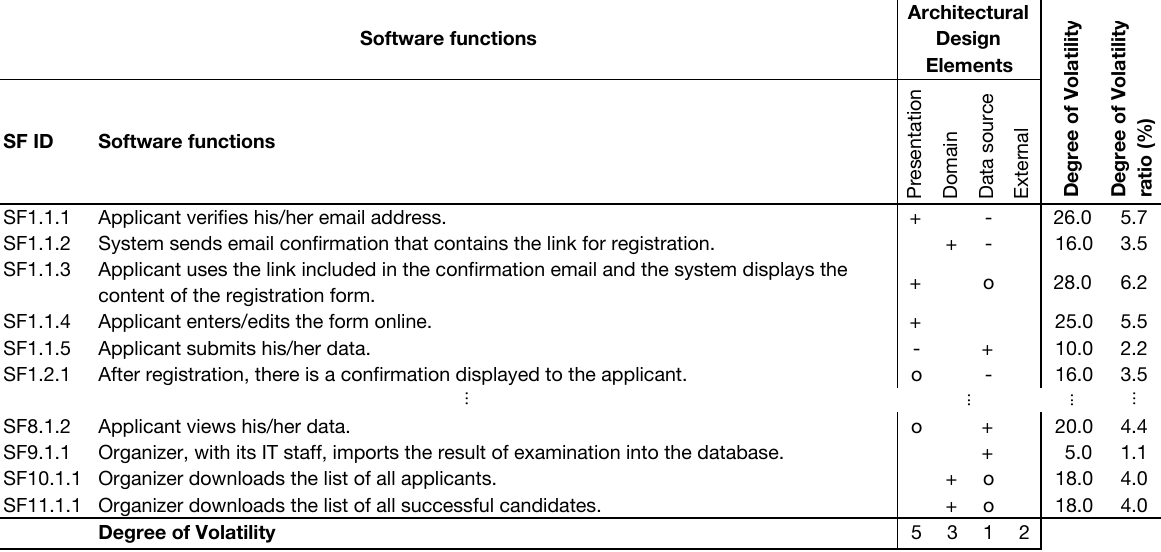
Table 6. Calculation of the degree of volatility of the software functions from the degree of volatility of the architectural design elements